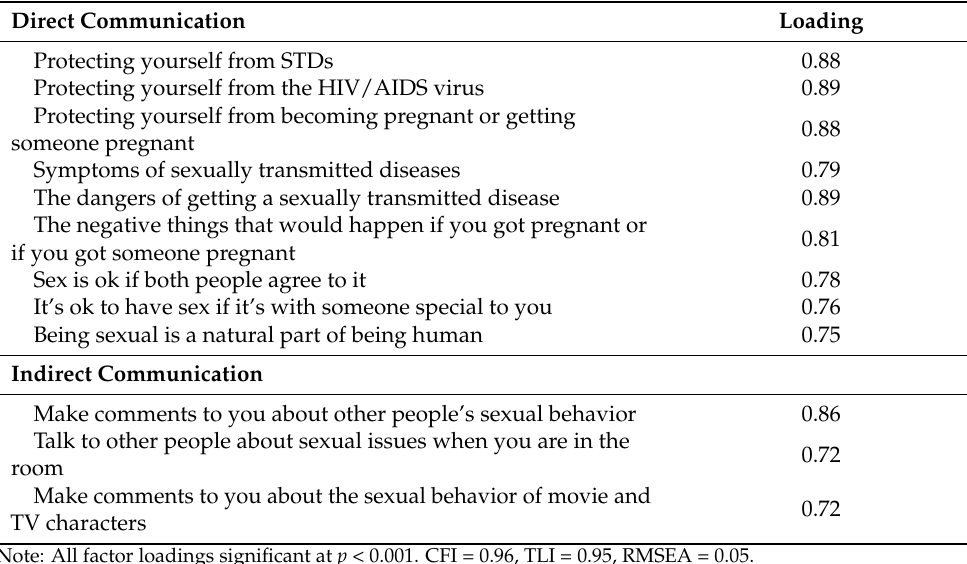
Table 2. Direct and indirect communication items and standardized factor